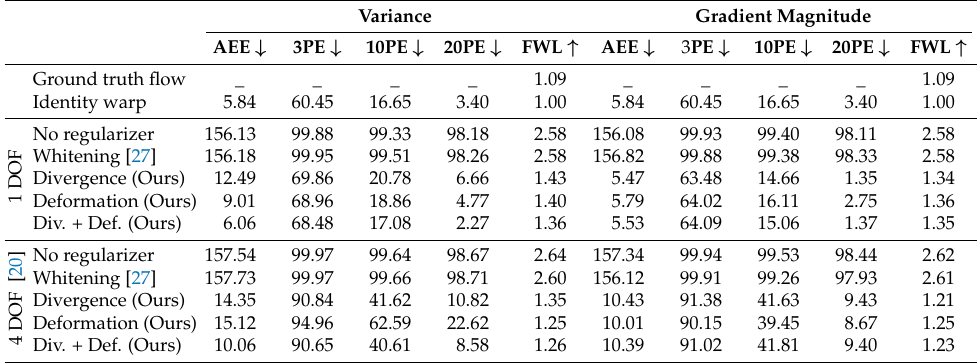
Table 2. Results of DSEC dataset